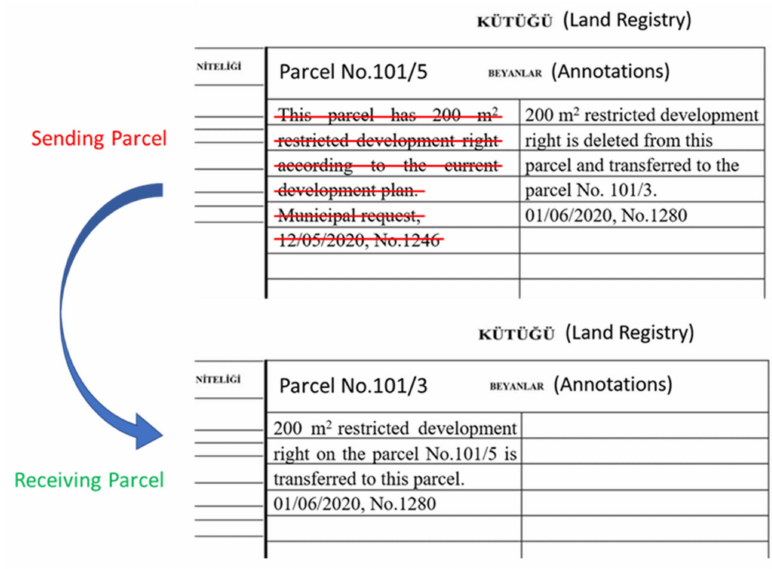
Figure 14. TDR update on land registry (only relevant part of the page of registry book is shown). Step